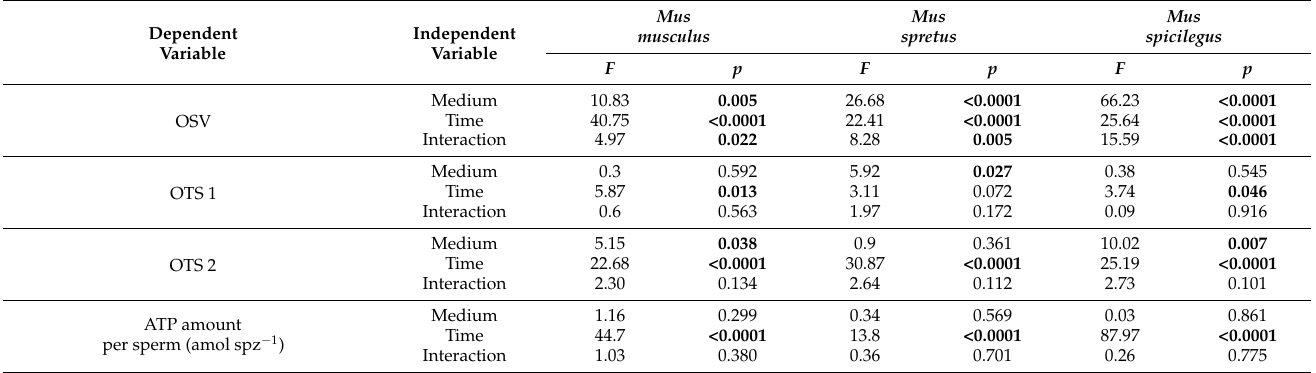
Table 7. Effect of time of incubation in non-capacitating or capacitating conditions (mT-H or mT-BH media, respectively) in high viscosity (2% PVP) on overall sperm velocity (OSV), overall trajectory shape (OTS 1 and OTS 2), and amount of ATP. Values of F and p are the results of repeated measures analyses (ANOVAs). Incubation conditions and time of incubation were defined as fixed factors, and the individual was defined as a random factor. Results highlighted in bold show significant differences in statistical analysis ( p <